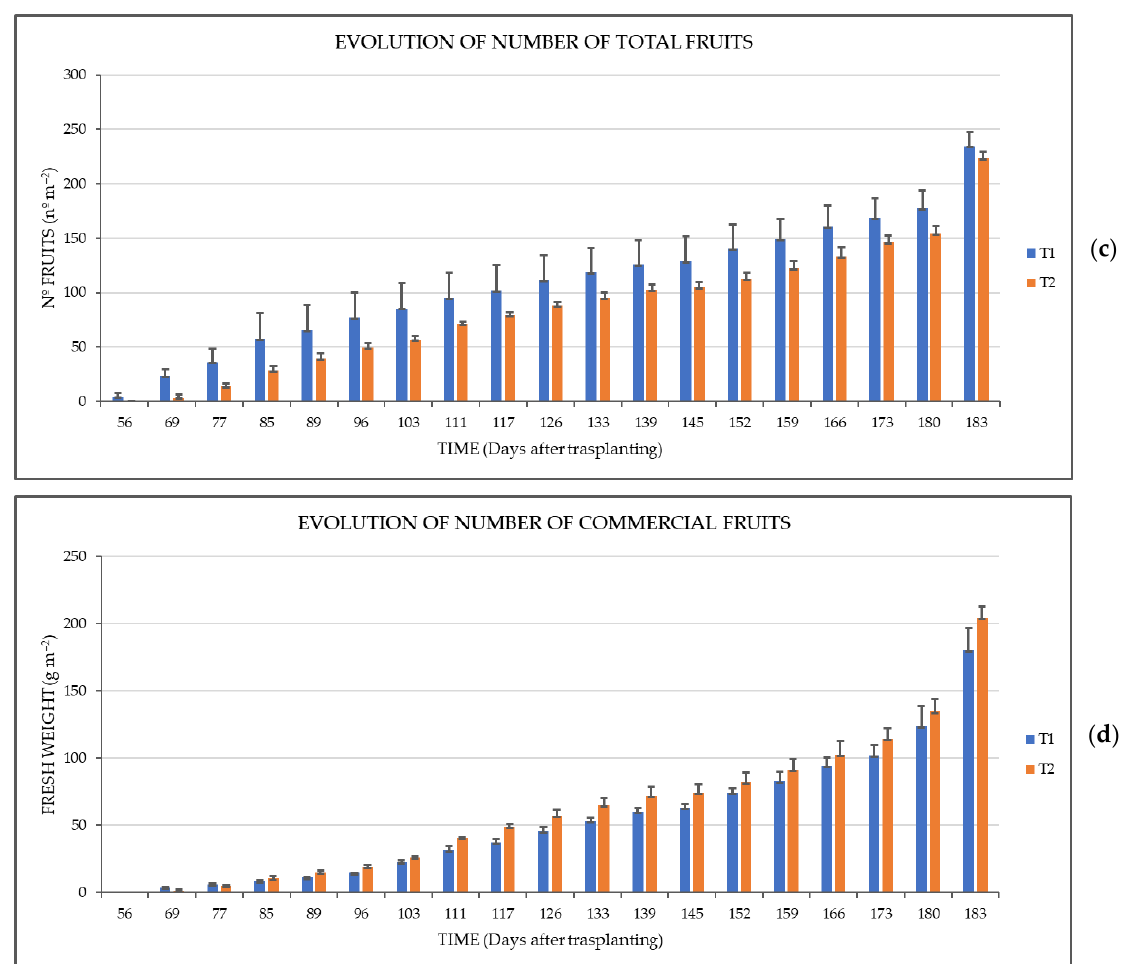
Figure 5. Yield of tomato crops grown in soil: ( a , b ) evolution of fresh weight accumulated of total yield and commercial yield; ( c , d ) evolution of total and commercial number of fruits accumulated.